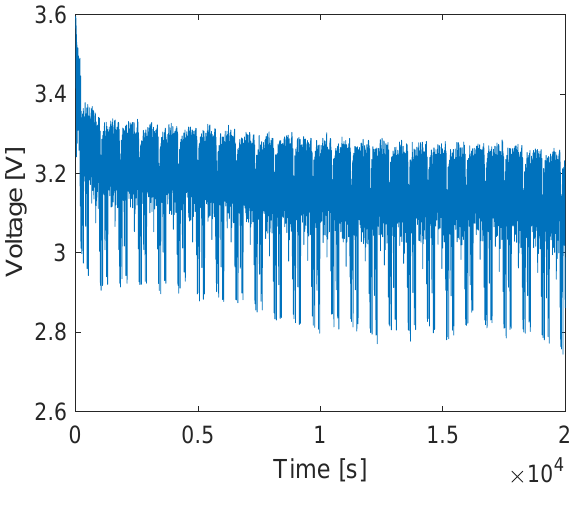
Figure 4. Terminal voltage of the battery.